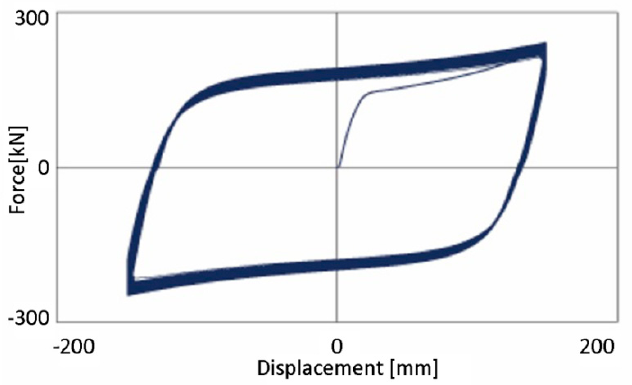
Figure 6. Experimental hysteretic cycles of a steel hysteretic dissipater with BRAD.